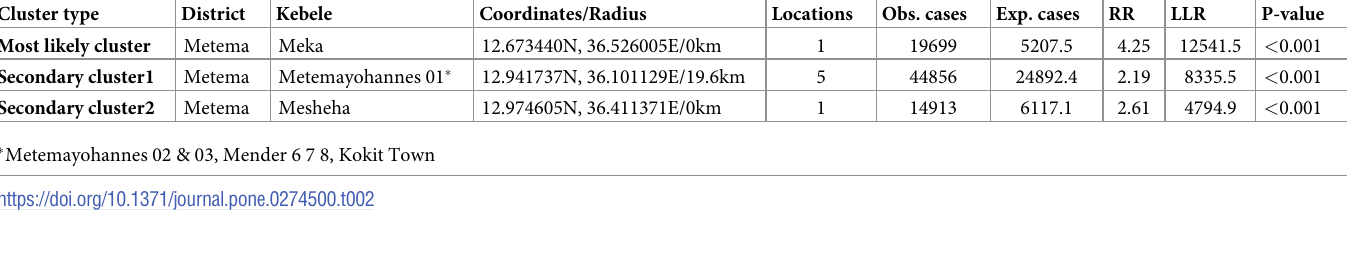
Table 2. Most likely and secondary clusters of malaria cases in Metema and Gendawuha districts between epi week 37/2013 and 38/2018. Cluster